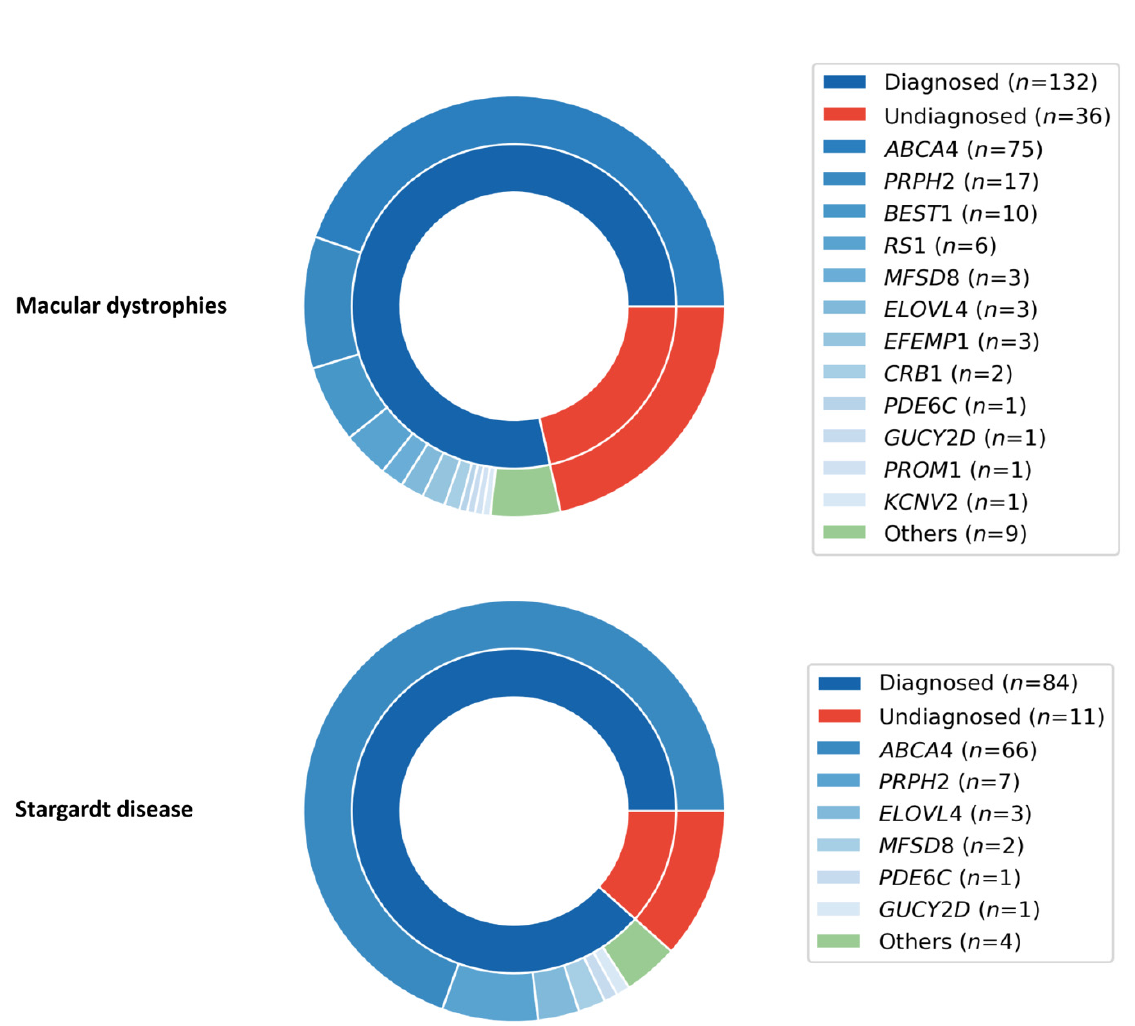
sub-cohort. Nested pie charts depicting diagnostic yield (inner ring) and the identified contributing loci (outer ring) for